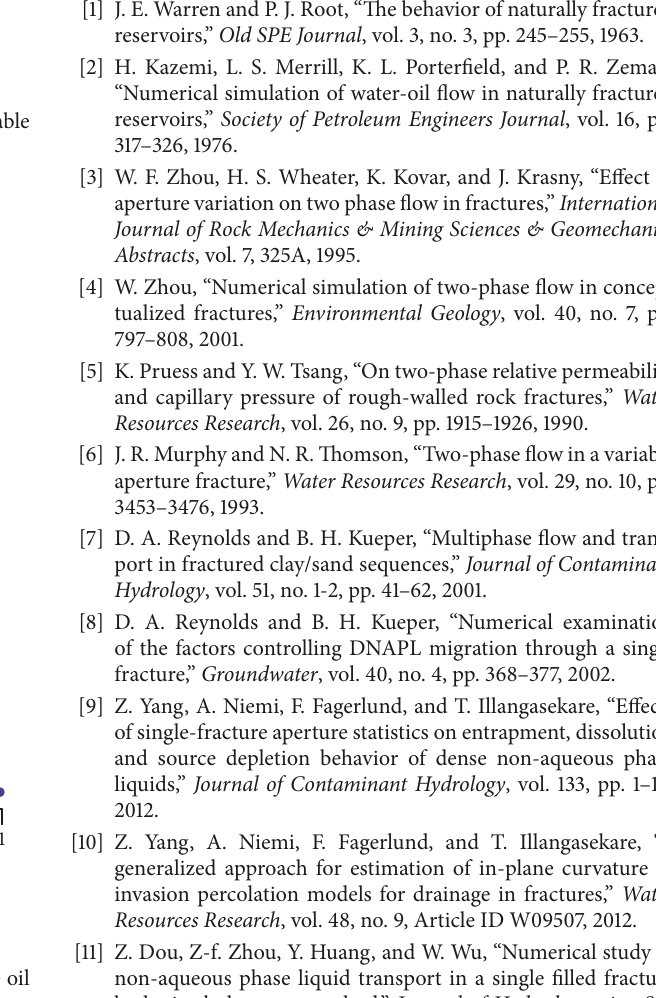
Figure 16: Relationship between the invasion pressure of crude oil and the volume fraction of water in the fracture for different contact angles at time 10s (FD =